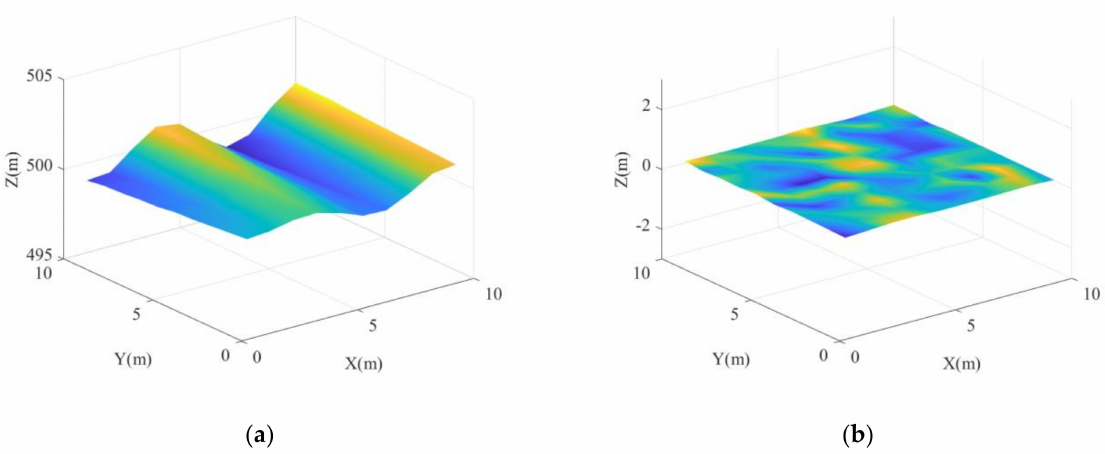
Figure 15. ( a ) Reconstructed 3D imaging result by using the proposed method; ( b ) The difference between the reconstructed and the ideal 3D imaging